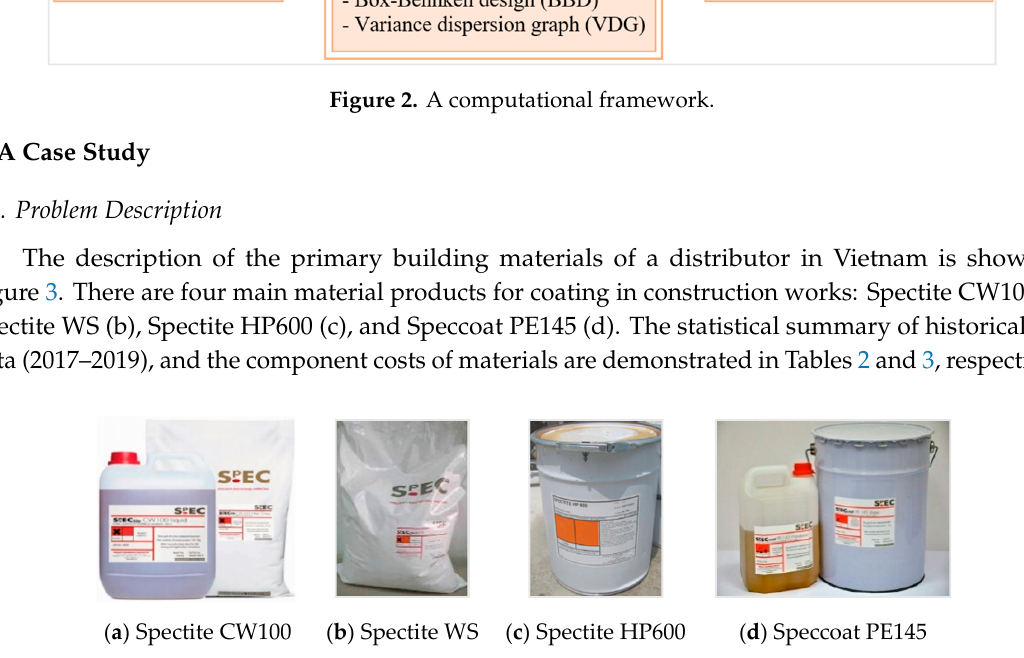
Figure 3. List of the main materials group of the distributor.